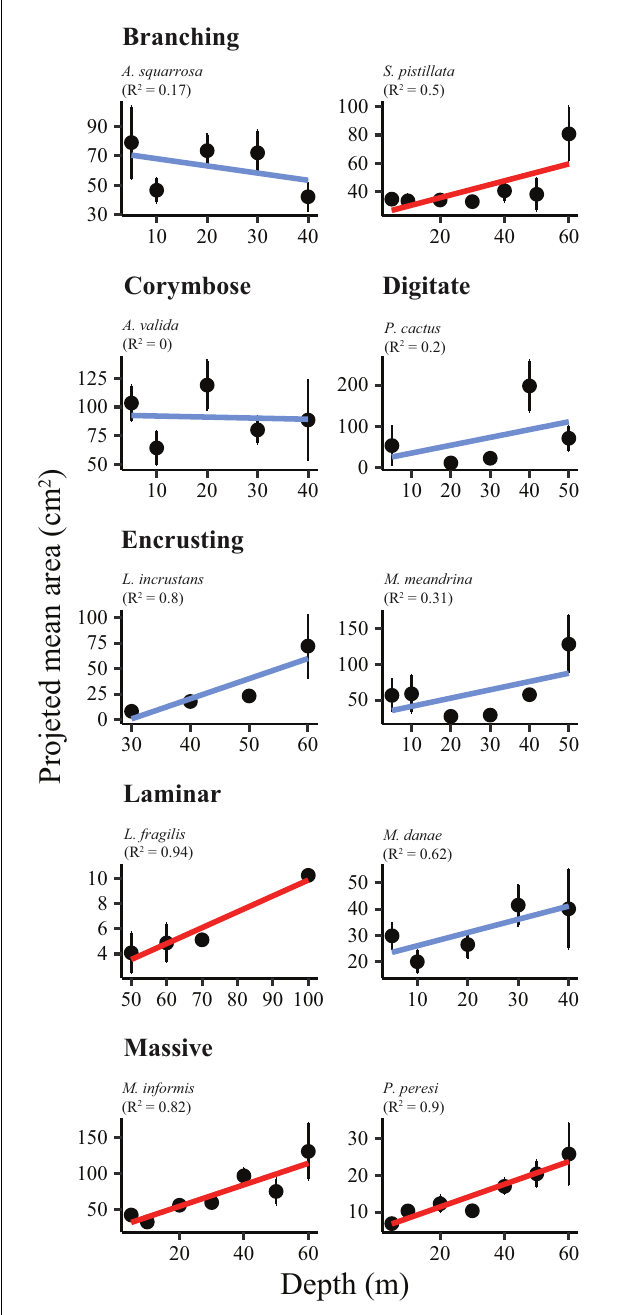
FIGURE 5 | Mean projected area (mean g ; cm 2 ) of ten representative locally abundant scleractinian corals belonging to six morphological categories, along a depth gradient. Red trendlines denote significant correlation ( p < 0.05). The coefficient of determination (R 2 ) is given in